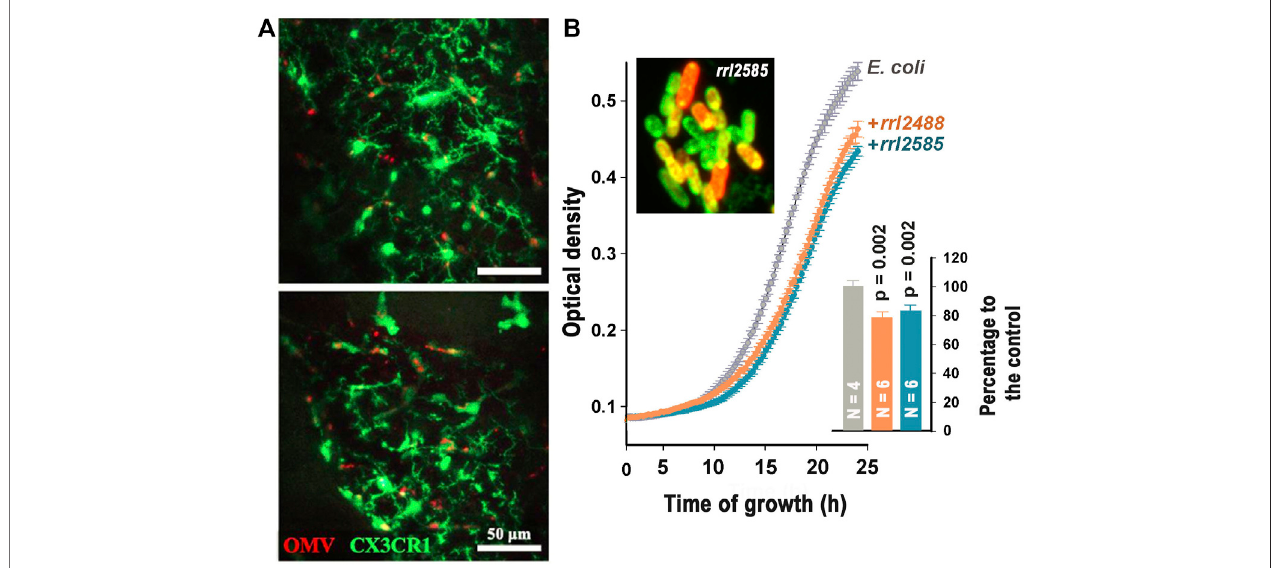
FIGURE1|(A) :Mergedintravitalimagesofmurinecortexcaptured 24 hafterinjectionof Aggregatibacteractinomycetemcomitans EVs(OMV)throughthetailvein showingcolocalizationofGFP-stainedmicroglialcellsandEVs(red fl uorescence).(Haetal.) (B) :Mergedimageofrrl_2585-Cy5(red fl uorescence)penetratedinto E.coli cells and suppression of E. coli growth dynamic by two RNA fragments from the secretome of R. rubrum (Markelova et